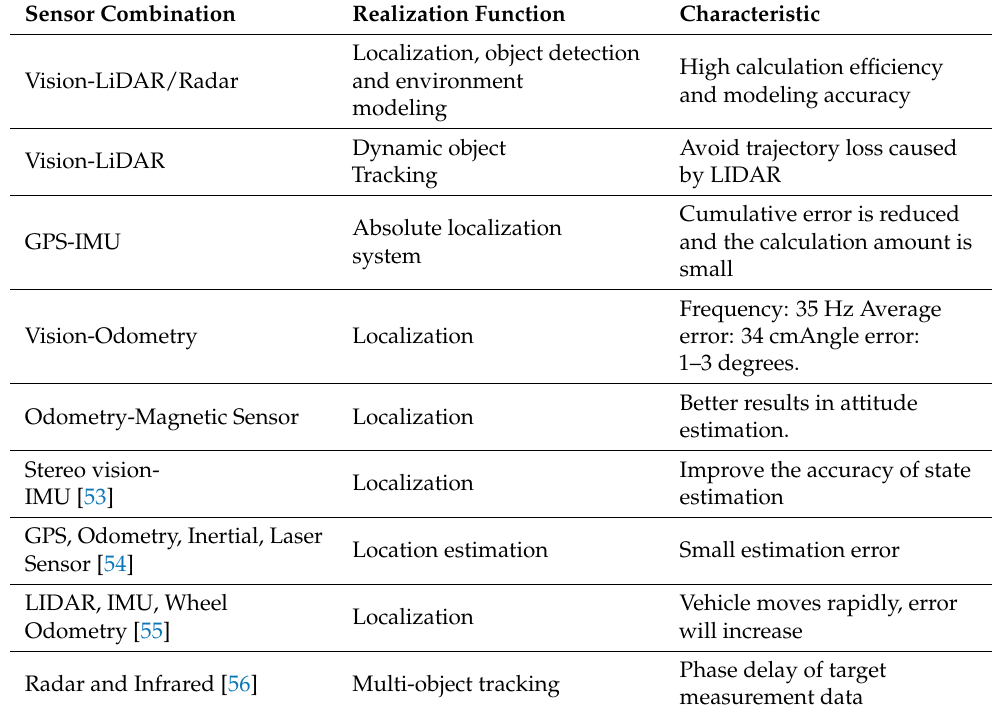
Table 4. Sensor Fusion